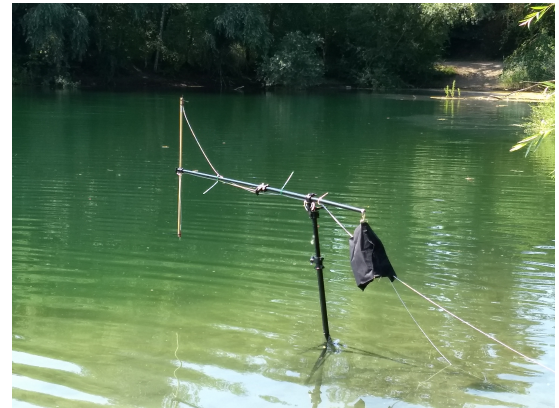
Figure 2. Measurement setup of the RoX spectrometer at a natural water